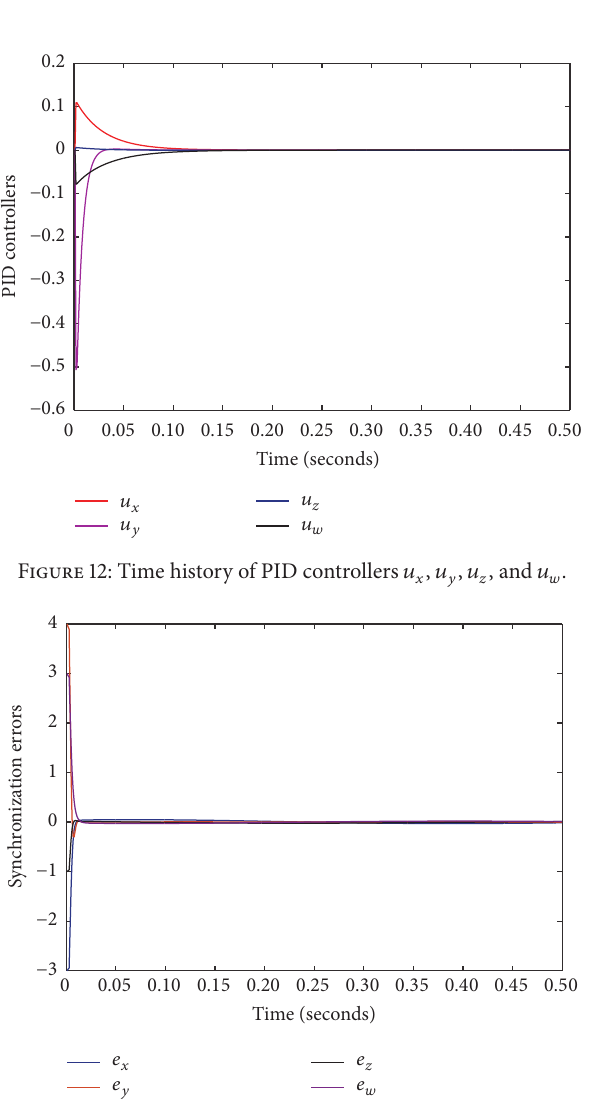
Figure 13: Time history of synchronization errors ( 𝑒 𝑥 ,𝑒 𝑦 ,𝑒 𝑧 ,𝑒 𝑤